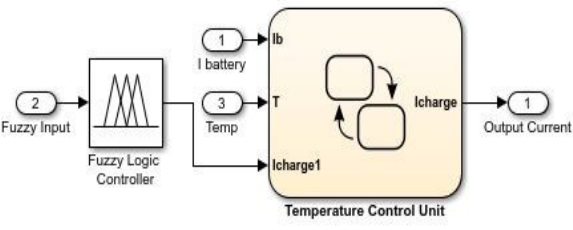
Figure 9. Fuzzy logic controller and temperature control unit.